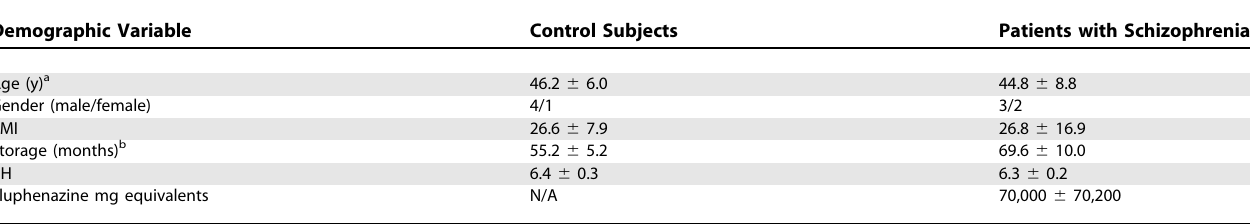
Table 5. Demographic Details of Subjects Investigated for Transthyretin Expression by Western Blot Analysis of Post-Mortem Brain Demographic